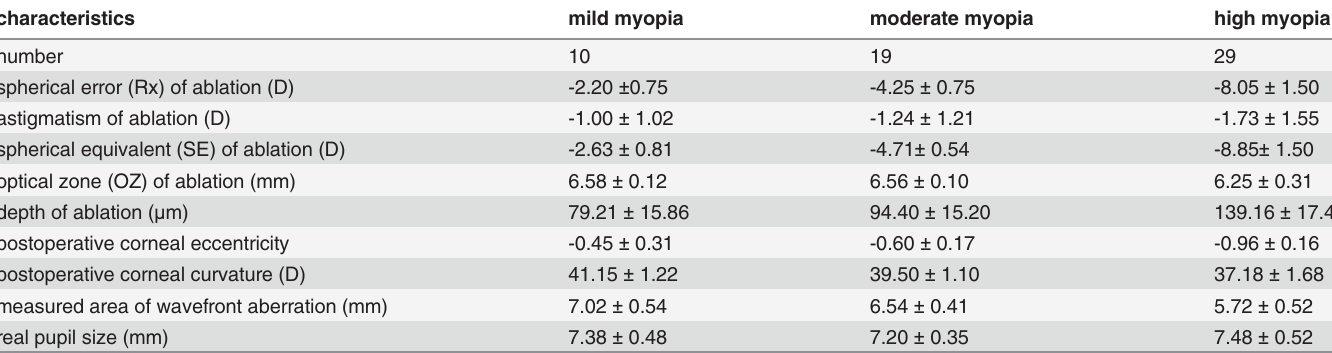
Table 2. Characteristics of corrected myopic eyes (mean ± S.D.).